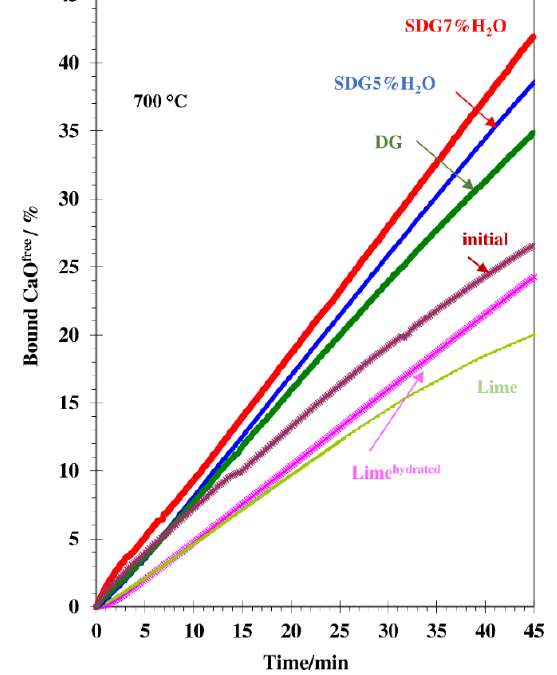
Figure 7. SO 2 binding efficiency of sorbents at 700 °C calculated on the content-free CaO bound (%).